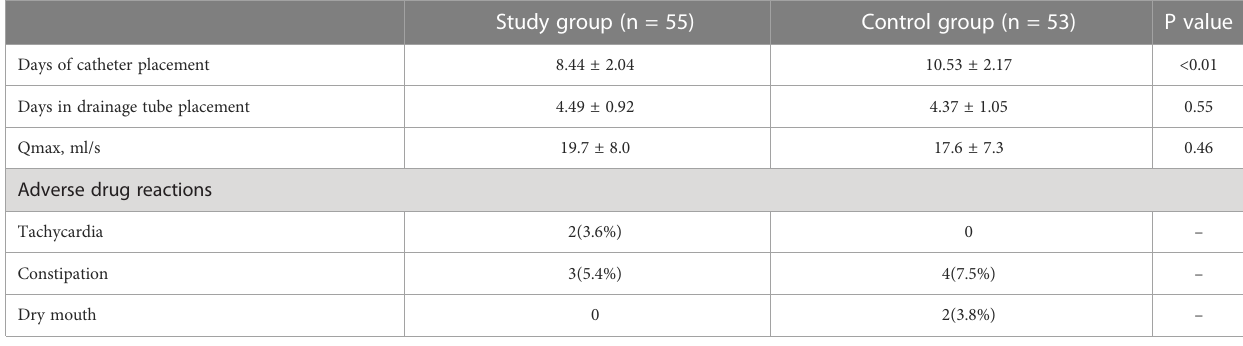
TABLE 3 One-month postoperative review of indicators and adverse drug